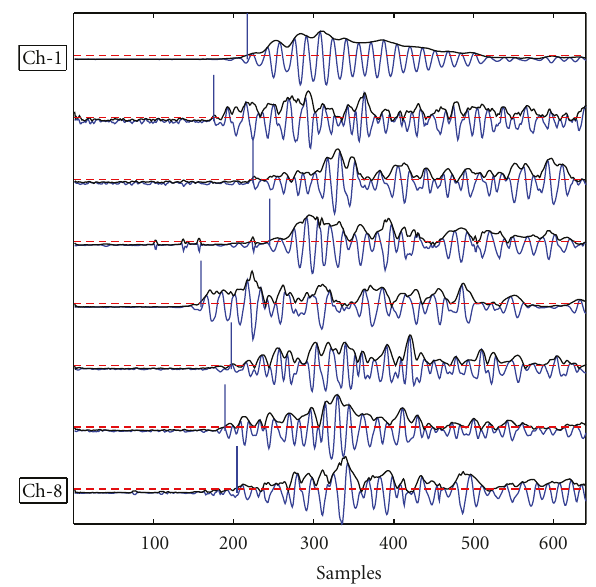
Figure 11: Sample cluster average and detected arrivals from eight sensors of SR1. TOA is marked with a vertical line on each channel. Note that the SVM classifier was trained on